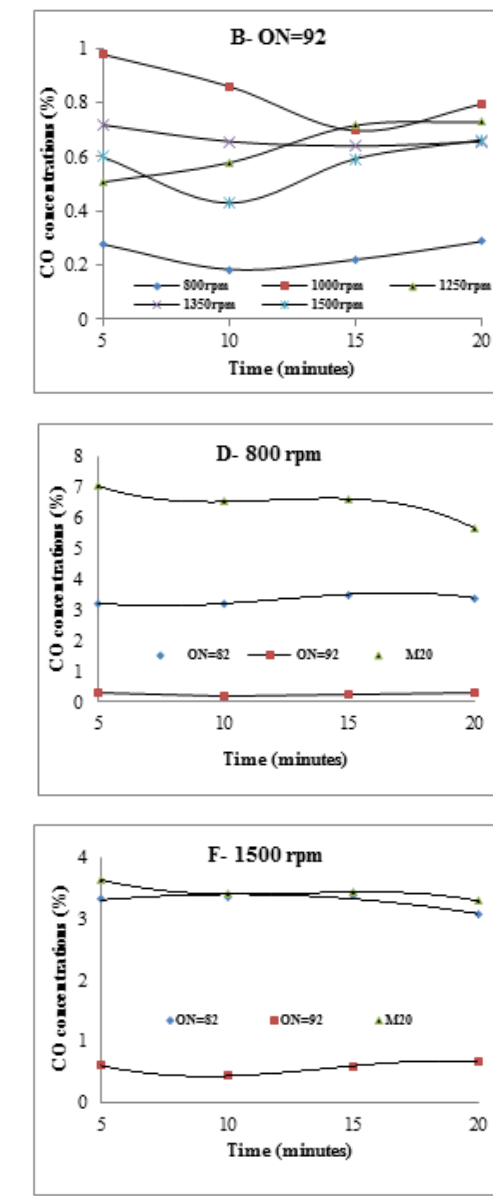
Fig. 4. the idling time effect on emitted CO for tested fuels at variable engines